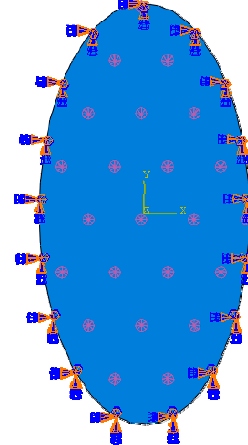
in Figure 4. For the discretisation, six-node triangular shell elements are defined with second-order shape functions. Each node had six degrees of freedom. The results of these simulations are compared in terms of three different criteria: equivalent stress (von Mises), displacement, and in-plane principal strain.